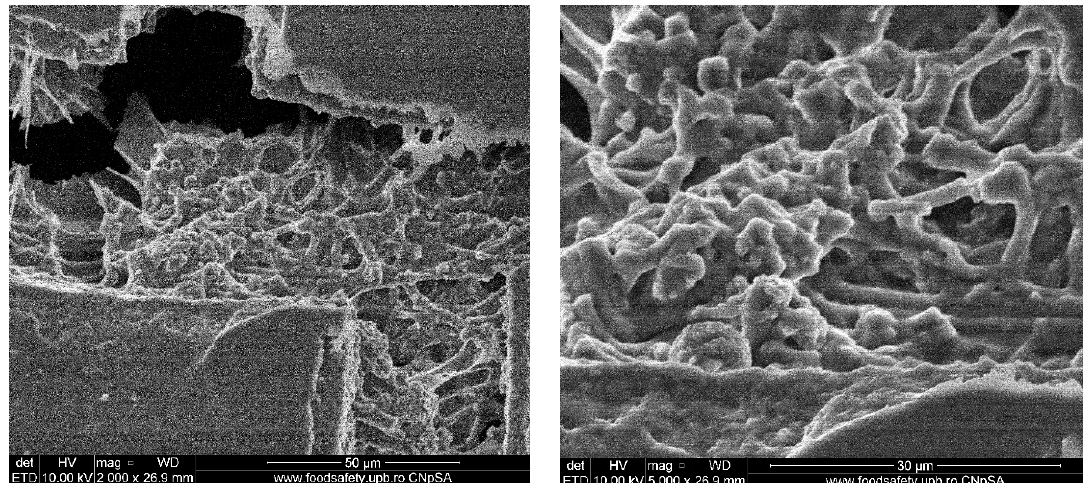
Figure 3. SEM micrographs of impregnated ESM after microwave thermal treatment (general aspect on the left and an up-close detail on the right ).